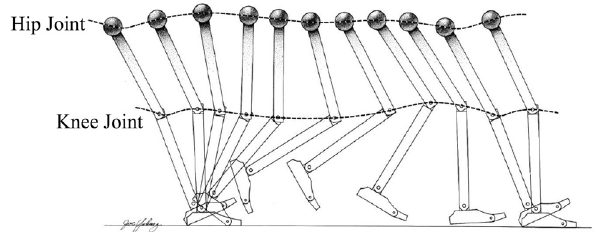
Figure 1: Lower limb motion during one stride [ 10 ] .